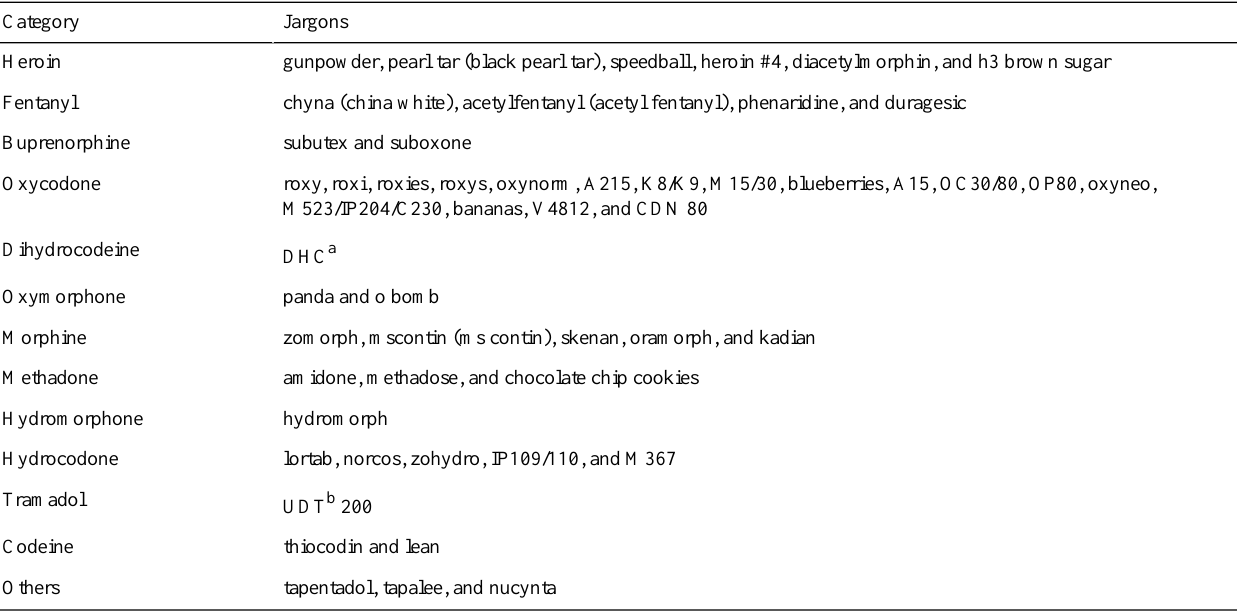
Table 2. Opioid jargons used in the anonymous online marketplaces and forums.